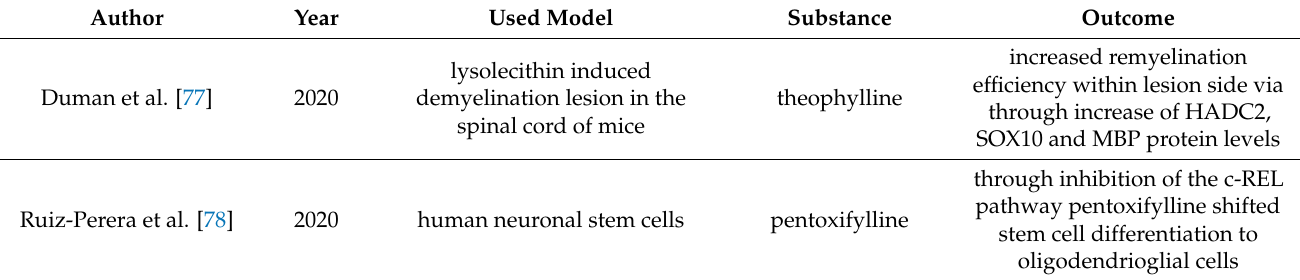
Figure 3. Summary of the molecular mechanisms reported in recent literature potentially mediating the beneficial effects of methylxanthines in respect to multiple sclerosis. Ac = Acetylation, eEF1A1 = eukaryotic translation elongation factor 1 alpha 1, HDAC2 = histone deacetylase 2, SOX10 = SRY-box transcription factor 10, MBP = myelin basic protein, ROS = reactive oxygen species, SOD1 = superoxide dismutase 1, c-Rel = proto-oncogene c-Rel, NSC = neuronal stem cells, PI3Kδ = phosphatidylinositol-3-kinase delta. Table 6. Summary of recent animal and cell culture studies investigating the relationship between methylxanthines and Multiple Sclerosis